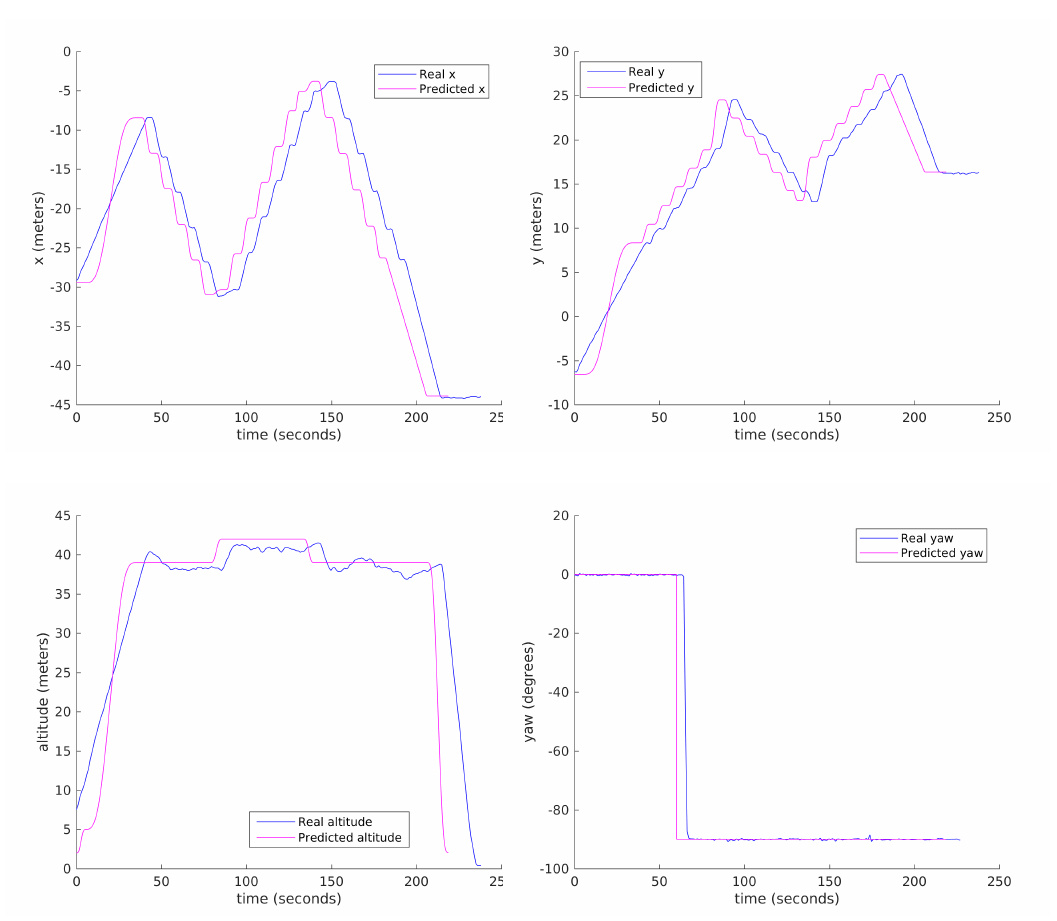
Figure 11. Automated execution vs MDS Simulated/Predicted results (x ( top-left ), y ( top-right ), altitude ( bottom-left ) and yaw ( bottom-right )).